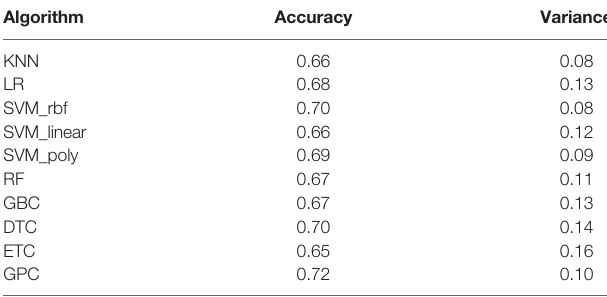
TABLE 2 | List of the accuracy and variance of different algorithms with 10-fold cross-validation in the training cohort. Algorithm